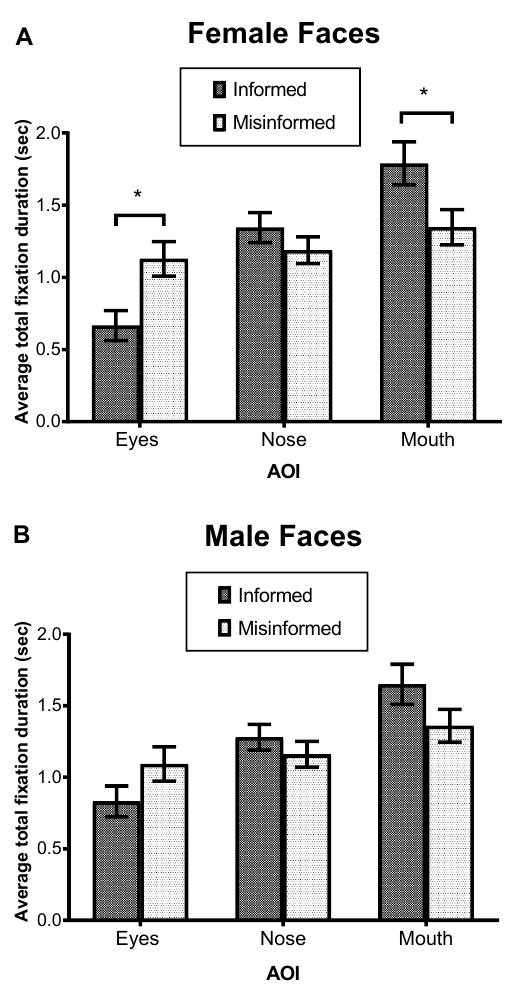
Figure 5. Average total fixation duration as a function of the areas of interest (AOI) for informed and misin- formed groups for (A) female faces and (B) male faces. Error bars show standard errors of the